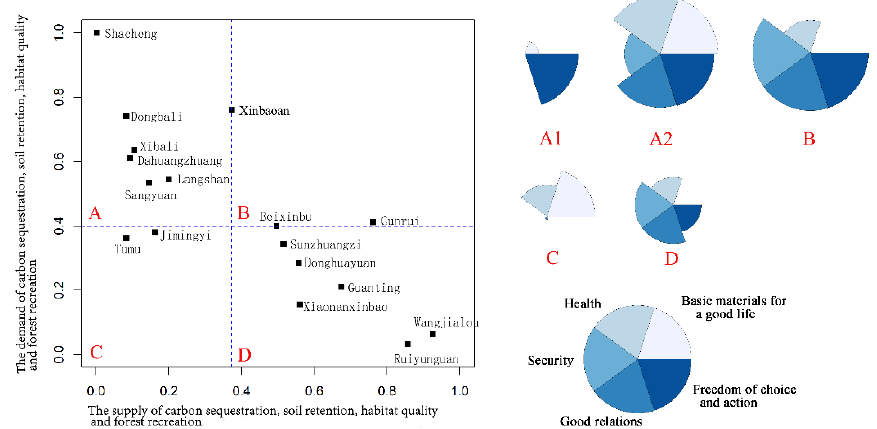
Figure 9. The well-being characteristics of four supply–demand types of carbon sequestration, soil retention, habitat quality, and forest recreation services.